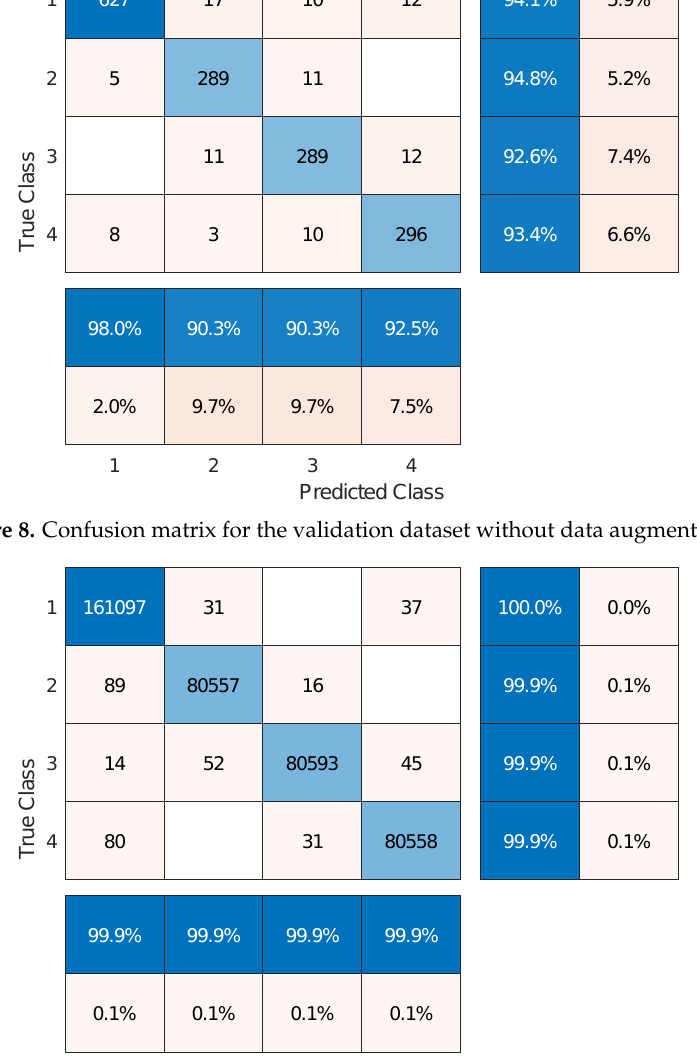
Table 7. Metrics for each label of the multiclassification problem and comparison between the datasets without and with data augmentation.